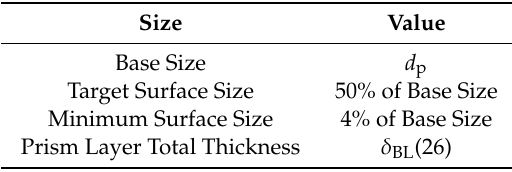
Table 2. Meshing properties in STAR-CCM + .